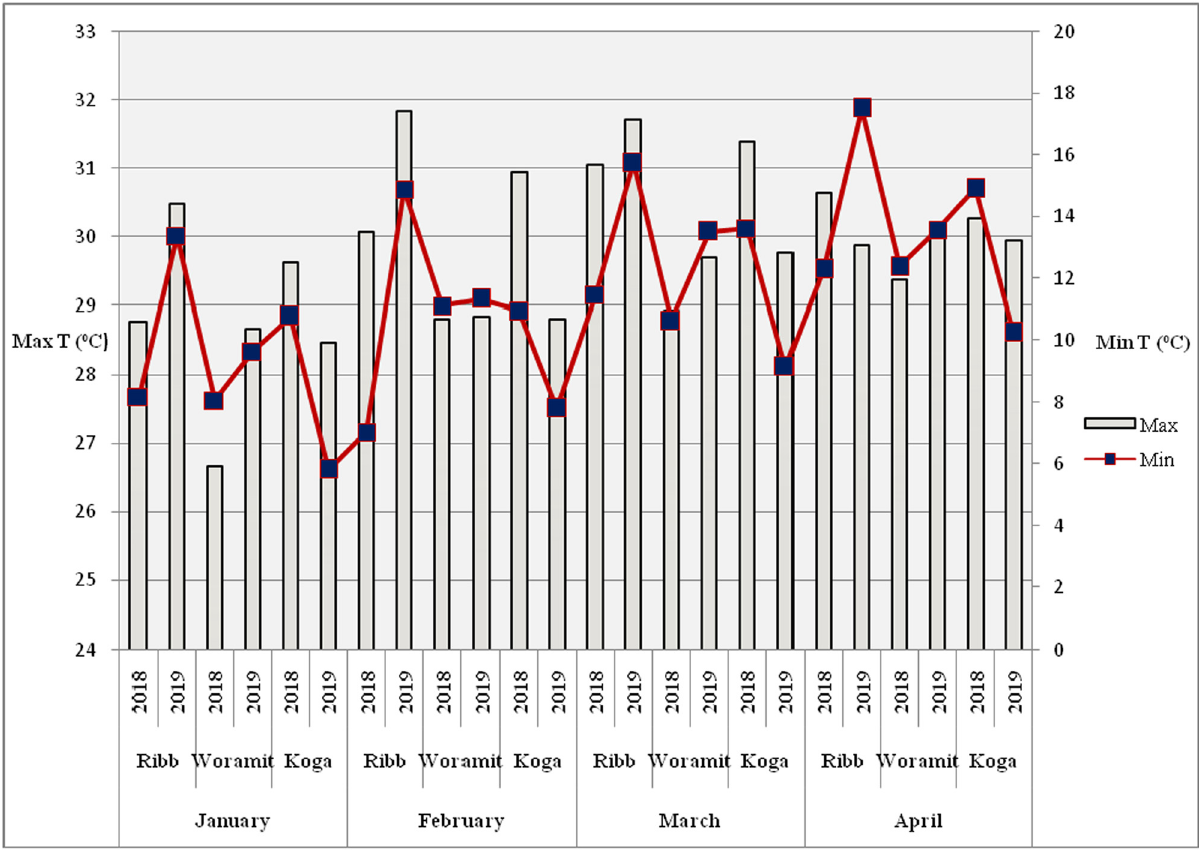
Figure 1: Temperatures of the experimental sites during the experimental